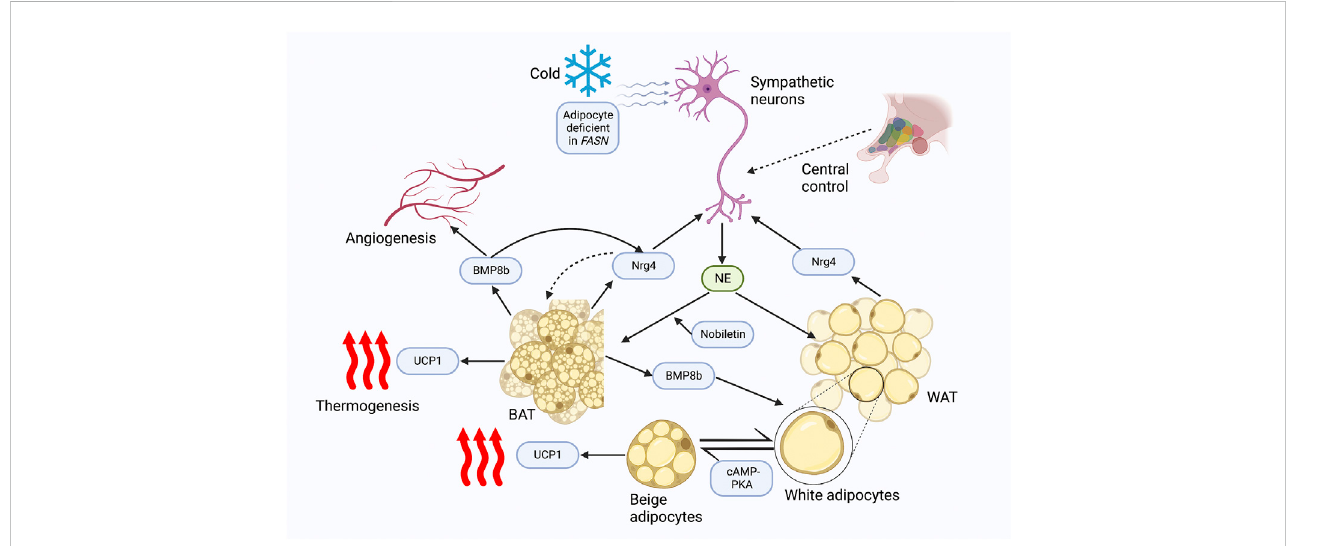
FIGURE 1 Nrg4 potentially regulates thermogenesis. Both cold and FASN de fi ciency promote sympathetic activation of BAT thermogenesis and Nrg4 production; FASN de fi ciency is independent of sympatheticneuron and Nrg4, whereas cold is dependent on sympatheticactivation and Nrg4 for optimal thermogenesis. Sympathetic neurons release NE to activate thermogenesis and WAT browning, while Nrg4, mainly secreted by BAT, promotes neurite growth, and thus increases adipose tissue innervation. BMP8b secreted by BAT can increase innervation of adipose tissue by promoting Nrg4 expression and promote angiogenesis, which can lead to neurovascular remodeling. The cAMP-PKA pathway is involved in the browning of white adipocytes. A natural compound, nobiletin, promotes β -adrenergic stimulation to increase Nrg4 expression in in vitro experiments. Abbreviations: FASN, fatty acid synthase; BAT, brown adipose tissue; NE, norepinephrine; Nrg4, neuregulin four; BMP8b, bone morphogeneticprotein8b; UCP1, uncoupling protein-1; WAT, white adiposetissue; cAMP-PKA, cyclic AMP/protein kinase